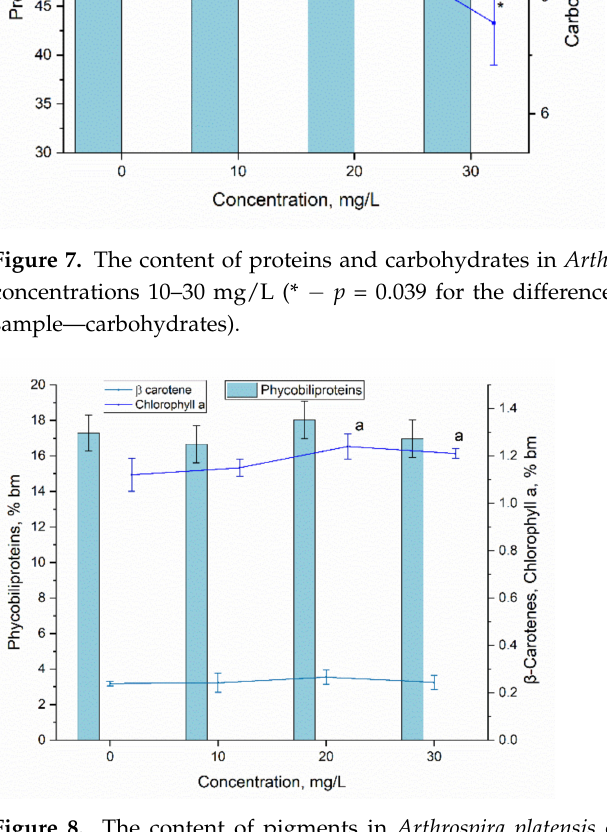
Figure 8. The content of pigments in Arthrospira platensis exposed to Er(III) at concentrations 10–30 mg/L, a— p < 0.05 for difference between control and experimental